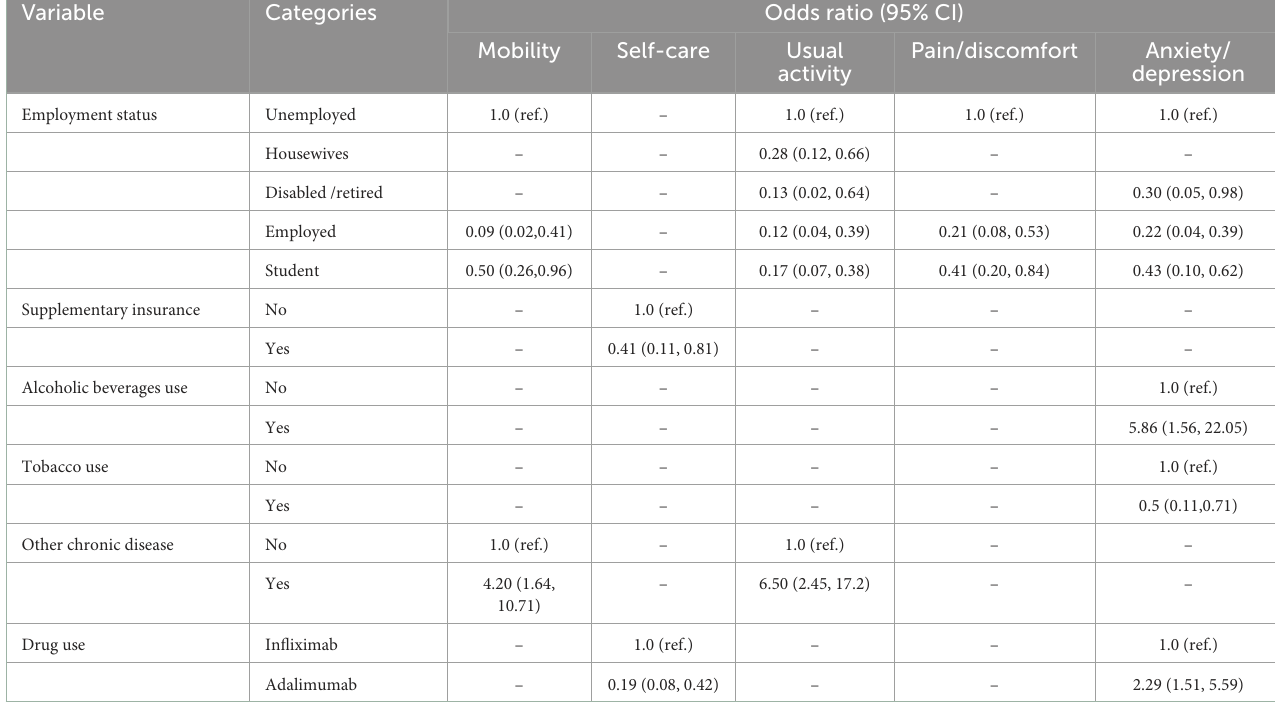
TABLE 5 Variables associated with “relatively or extreme problems” in each EQ-5D 3L dimensions using multivariate logistic